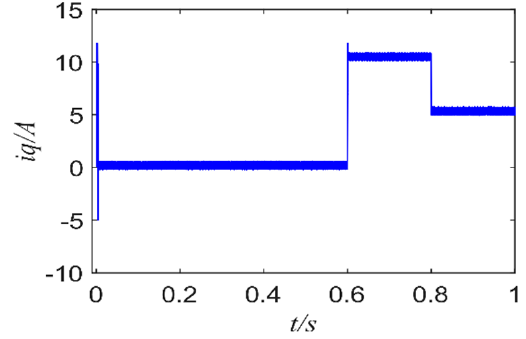
Figure 8. q -axis current of FCS-FMPCC.